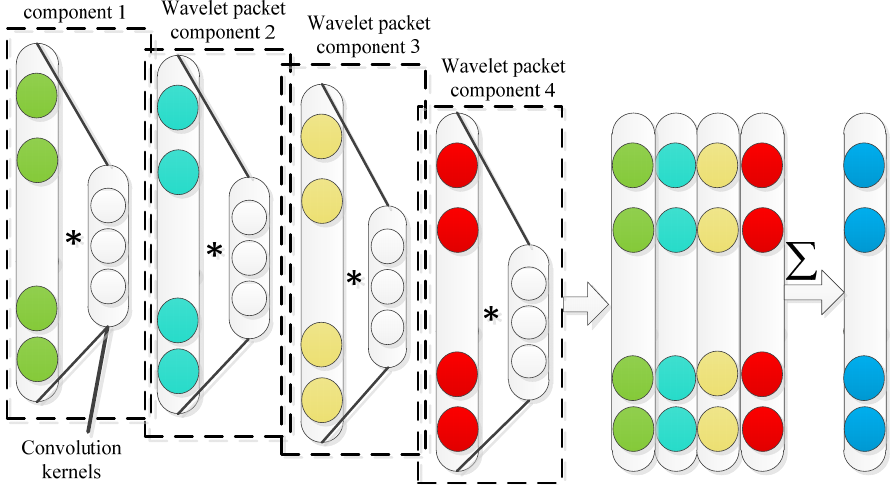
∗ represents the convolution